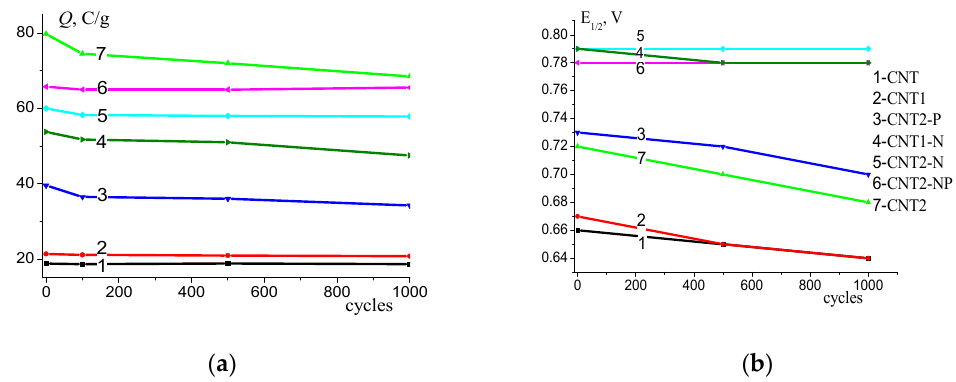
Figure 5. ( a ) Variation in electrochemically active surface area; ( b ) variation in half-wave potential during corrosion testing in O 2 -saturated 0.1 M KOH. The potential scan rate is 100 mV/s, m cnt = 0.15 mg/cm 2 .; ΔЕ = 0.6 ÷ 1.3 V (vs. RHE).